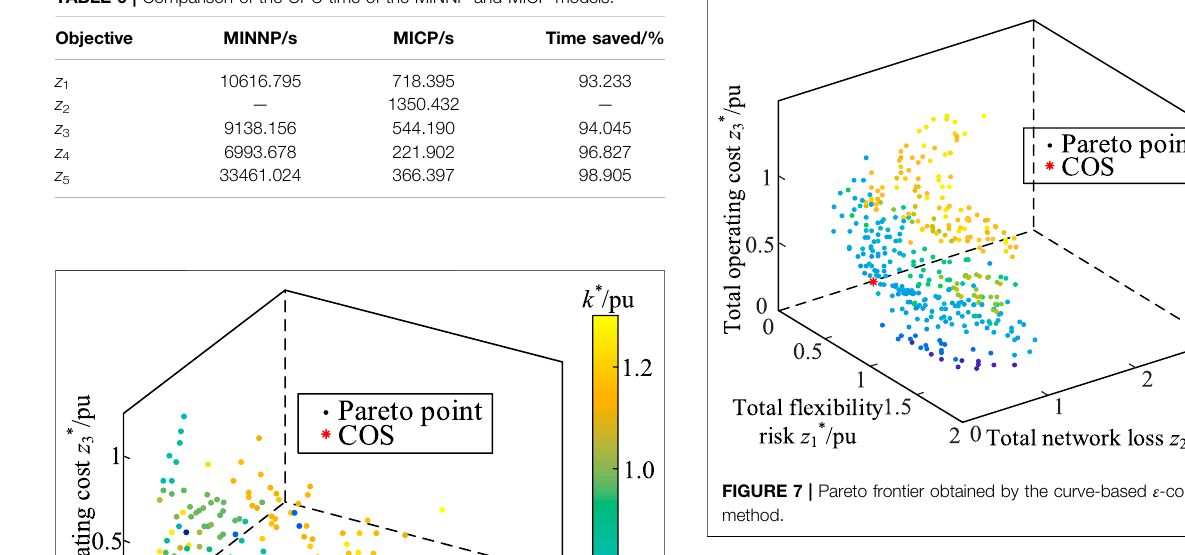
TABLE 6 | Comparison of the CPU time of the MINNP and MICP models.